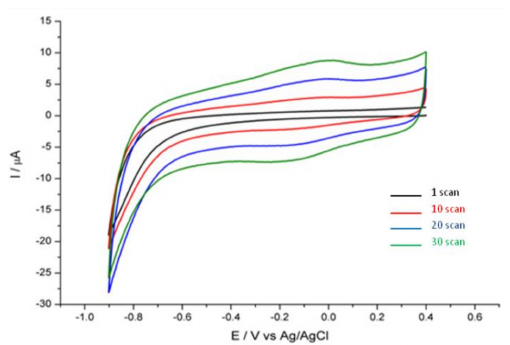
Figure 1. Cyclic voltammograms of the electrochemical reduction of graphene oxide at the glassy carbon (GC) electrode in 0.05 M phosphate buffer (PB) buffer (pH = 7.4) at 50 mV/s.